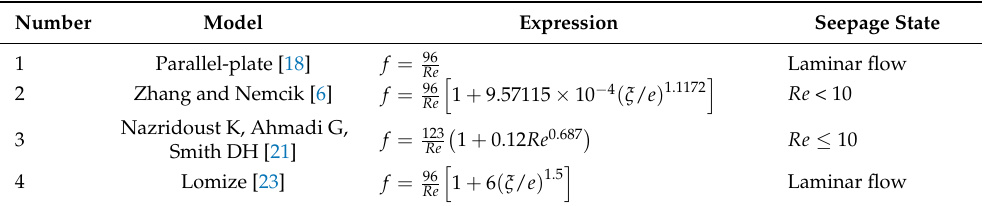
Table 1. Different frictional resistance coefficient